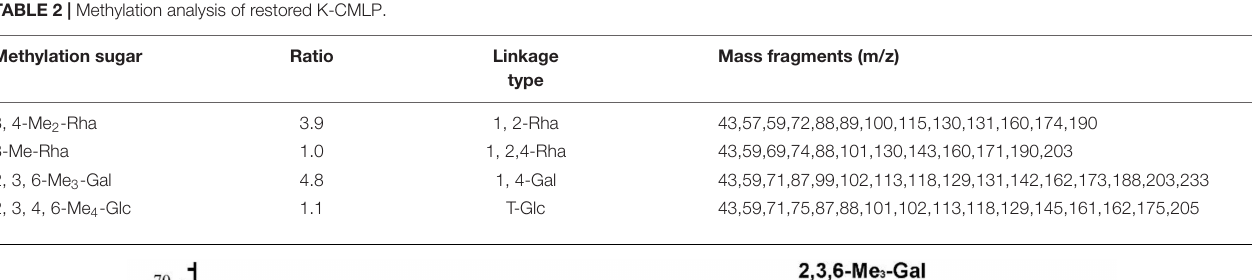
TABLE 2 | Methylation analysis of restored K-CMLP.